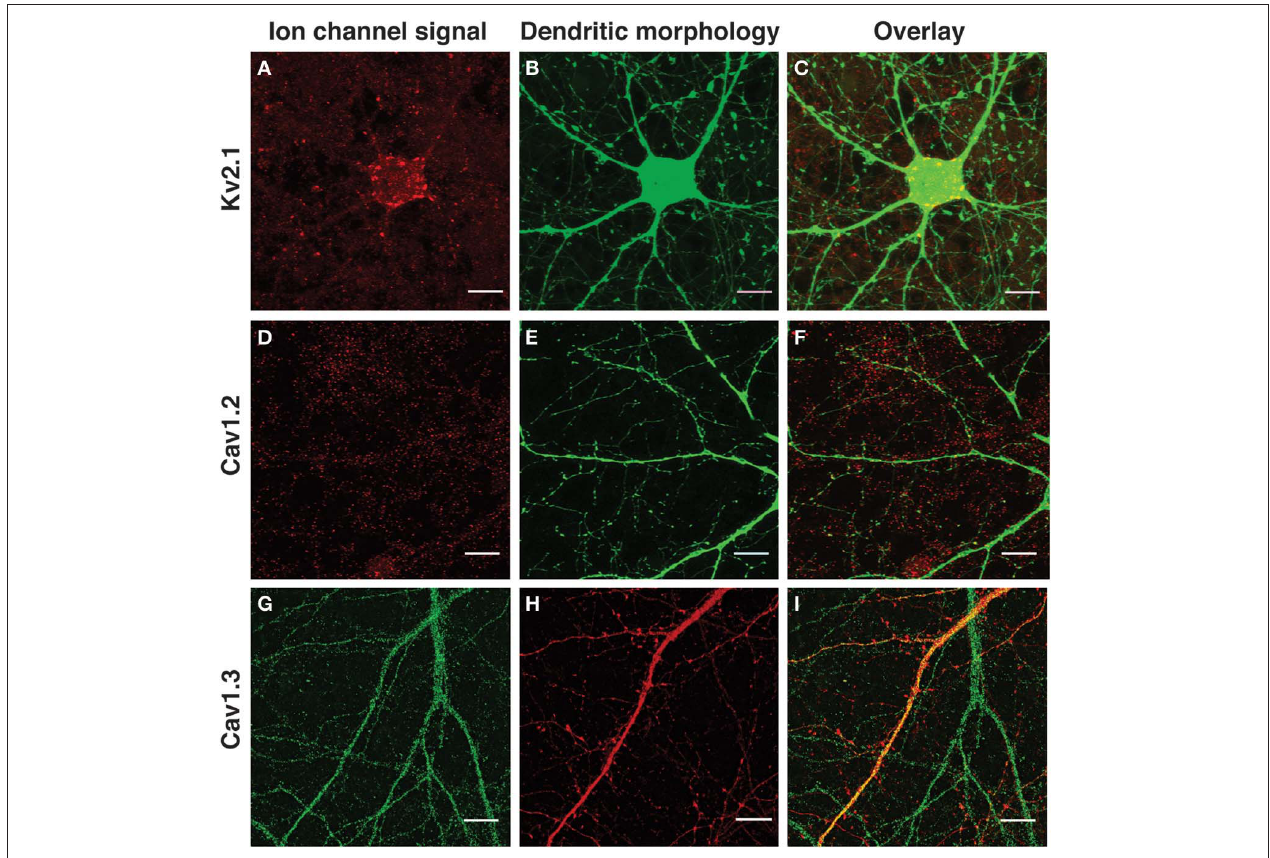
FIGURE 1 | Immunological detection of voltage-gated ion channel subunits in SAD (cid:2) G-labeled cultured neocortical neurons. (A,D,G) Immunofluorescence detection of endogenous ion channel signal. (B,E,H) Morphological labeling of neuronal structure (mCherry or eGFP). (C,F,I) Overlay of ion channel signal and neuronal morphology. (A,C) Kv2.1; (D,F)